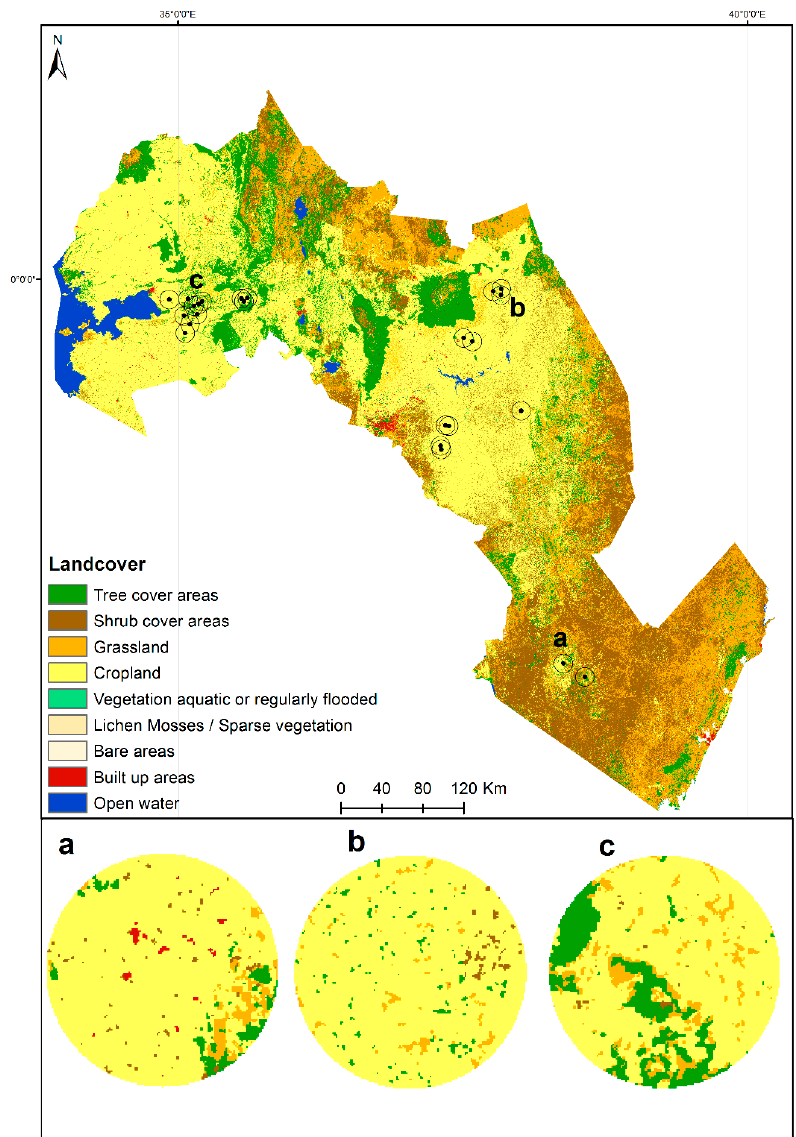
Figure 3. A 20-m spatial resolution land use/land cover map for the study area generated by the Climate Change Initiative (CCI) Land Cover (LC) team. Using yearly Sentinel-2 observations. ( a – c ) represent zoomed buffers of 1500 m radius each around certain representative African citrus triozid (ACT) occurrence points.